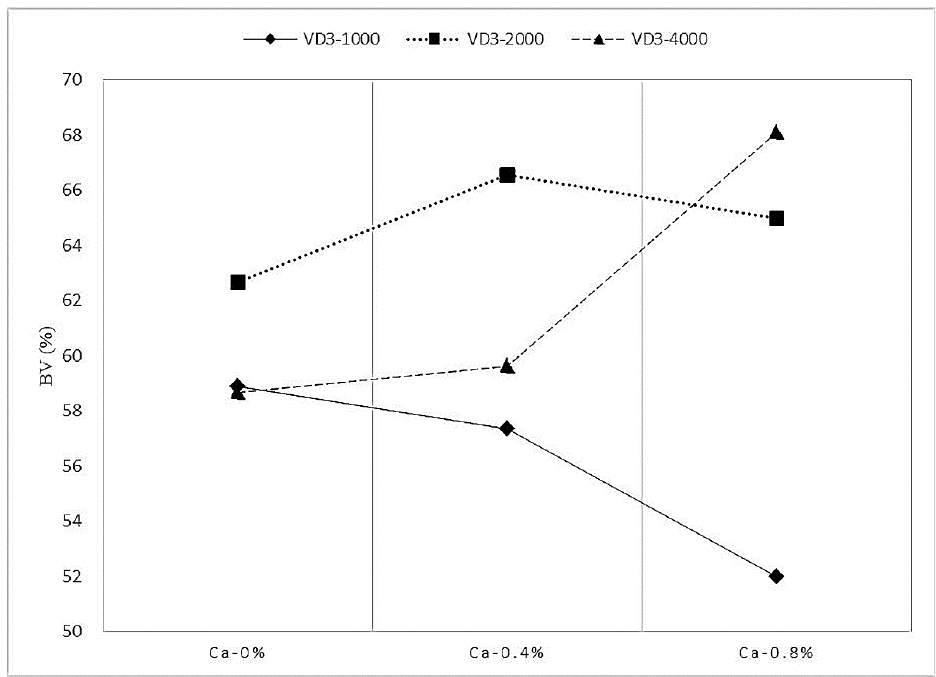
Figure 2. The effect of the interaction between Ca and VD 3 on the BV of protein in growing blue foxes. VD 3 = vitamin D 3 . BV = biological value. Table 4. Effects of dietary Ca and VD 3 supplemental levels on N metabolism in growing blue foxes (LS means ± SEM).